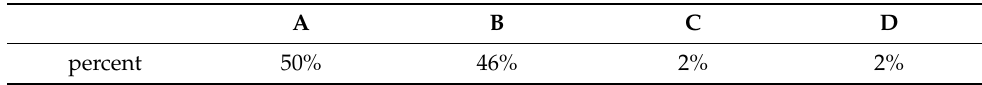
Table 5. Proportion of four types of